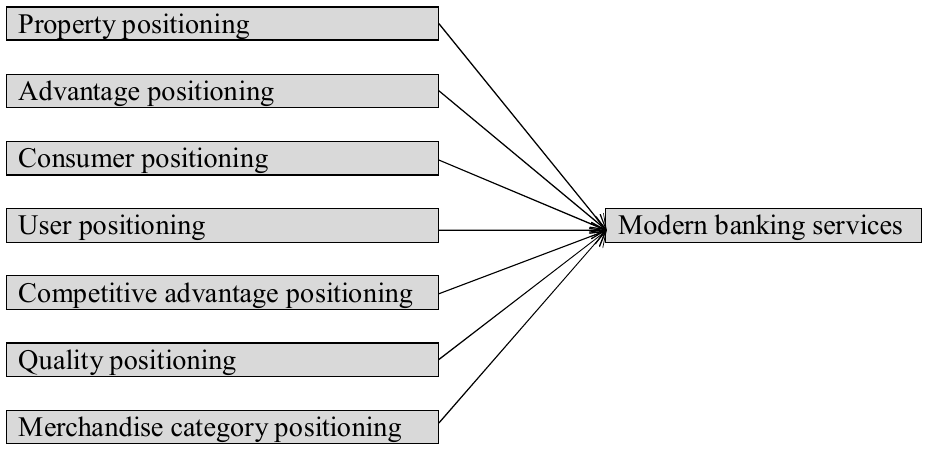
Fig. 1. The proposed